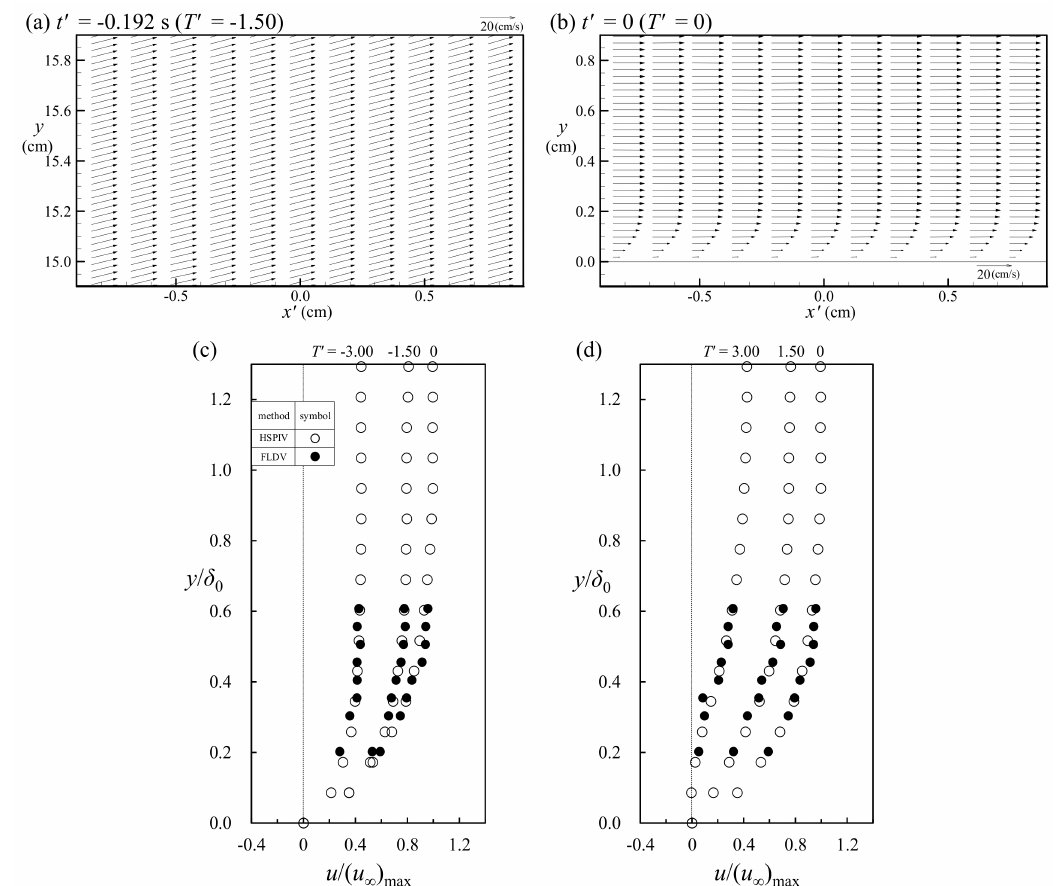
Figure 3. ( a , b ) Spatial variations of external and near-bottom velocity fields measured over horizontal bottom at t’ = − 0.135 and 0 s (i.e., T’ = − 1.50 and 0), respectively; and ( c , d ) comparison of horizontal velocity profiles in boundary layer measured by HSPIV with those obtained by fiber-optic laser Doppler velocimetry (Ho [32]) for different non-dimensional times (Case 3). Note that wave height and still water depth for this study are H 0 = 2.74 cm and h 0 = 16.0 cm, and counterparts for Ho [32] are H 0 = 1.20 cm and h 0 = 7.0 cm, both having identical value of H 0 / h 0 =